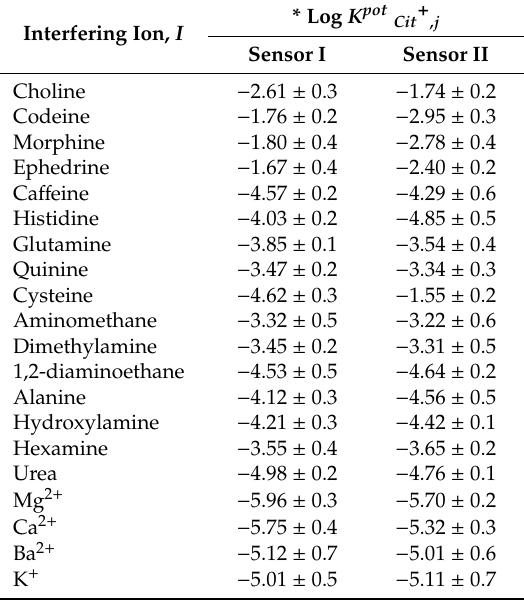
Table 2. Selectivity coe ffi cients ( K pot Cit + ,j ) of citicoline membrane based sensors.